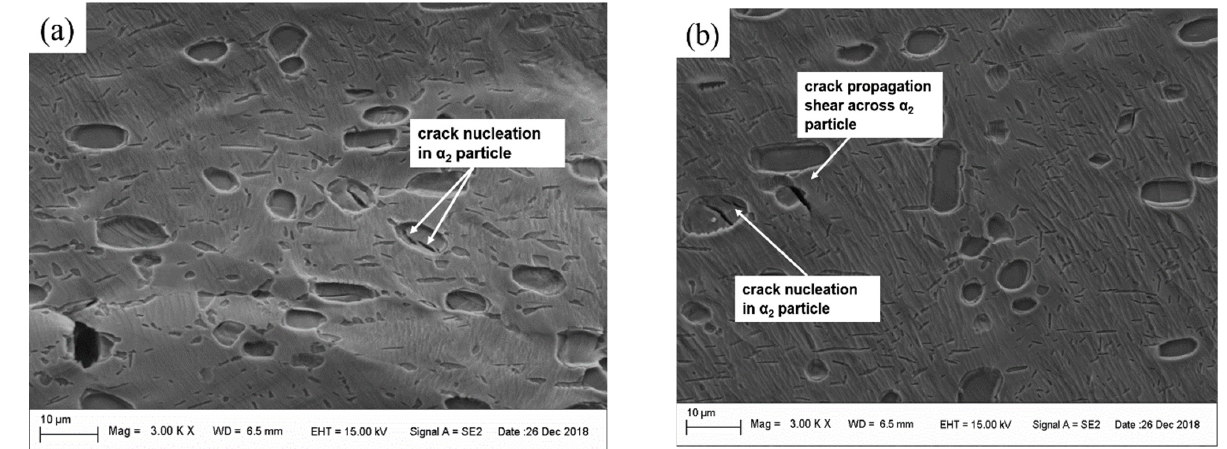
Figure 15. The SEM micrographs of ( a ) crack nucleation within the α 2 particle; ( b ) crack propagation shear across the α 2 particle.